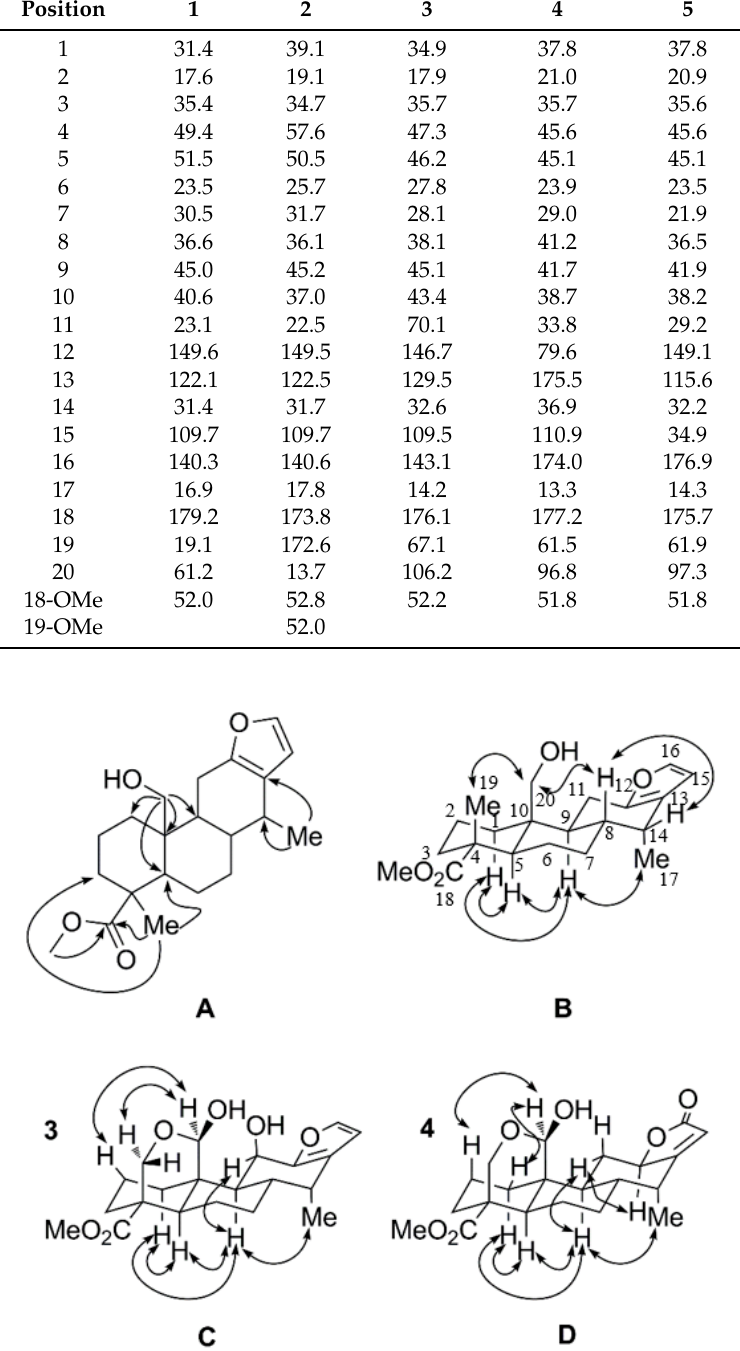
Table 2. 13 C-NMR spectroscopic data (125 MHz, CDCl 3 ) for compounds 1 ‒ 5 ( δ C in ppm).